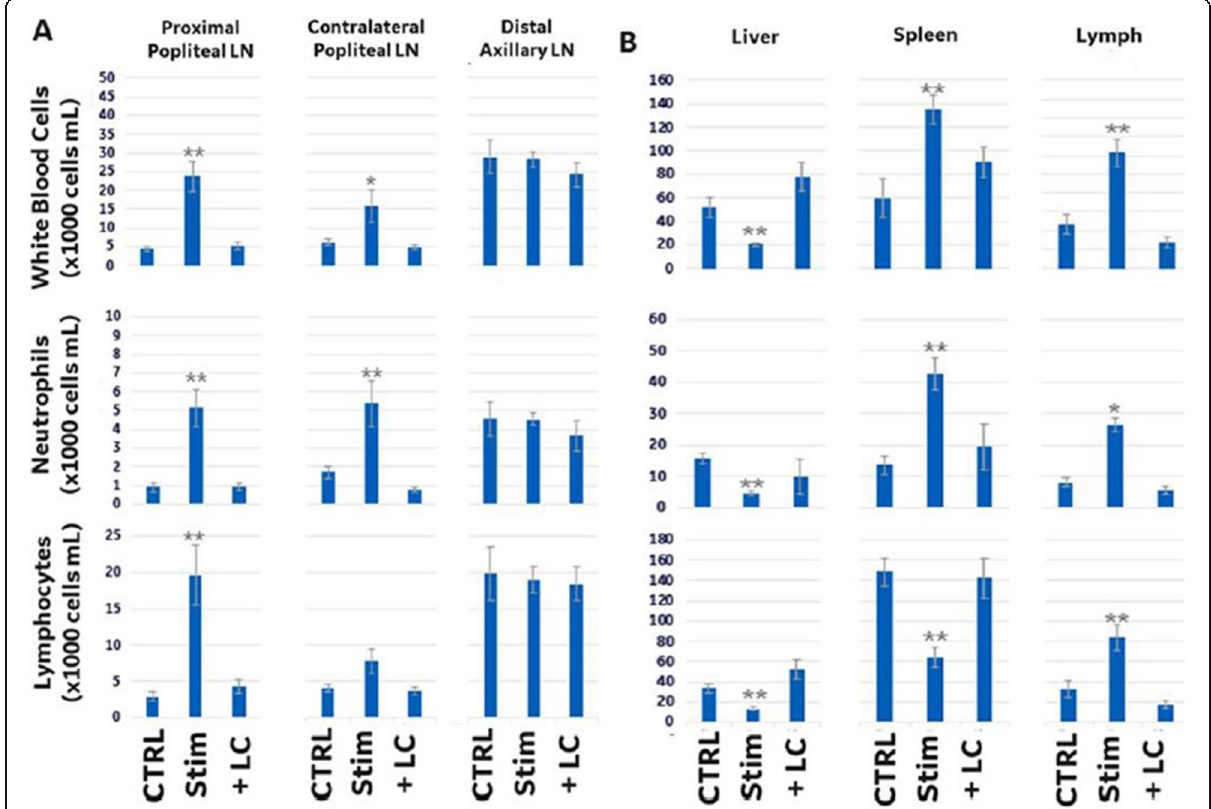
Fig. 2 a Total white blood cell (WBC), lymphocyte (LY), and neutrophil (NE) numbers within the excised lymph nodes (see materials and methods for tissue collection and analysis details). The popliteal lymph node directly adjacent to the sciatic nerve stimulation site was collected and analyzed (proximal popliteal LN), along with the contralateral popliteal lymph node from the non-stimulated leg (contralateral popliteal LN) and a distal axillary lymph node (distal axillary LN). b Total white blood cell (WBC), lymphocyte (LY), and neutrophil (NE) numbers within immune sites distal to the stimulation site, including the liver, spleen, and lymphatic fluid (collected from the lymphatic duct). N = 9. One way ANOVA with multiple comparison analysis * = p ≤ 0.05, ** = p ≤ 0.005,*** = p ≤ 0.0005;